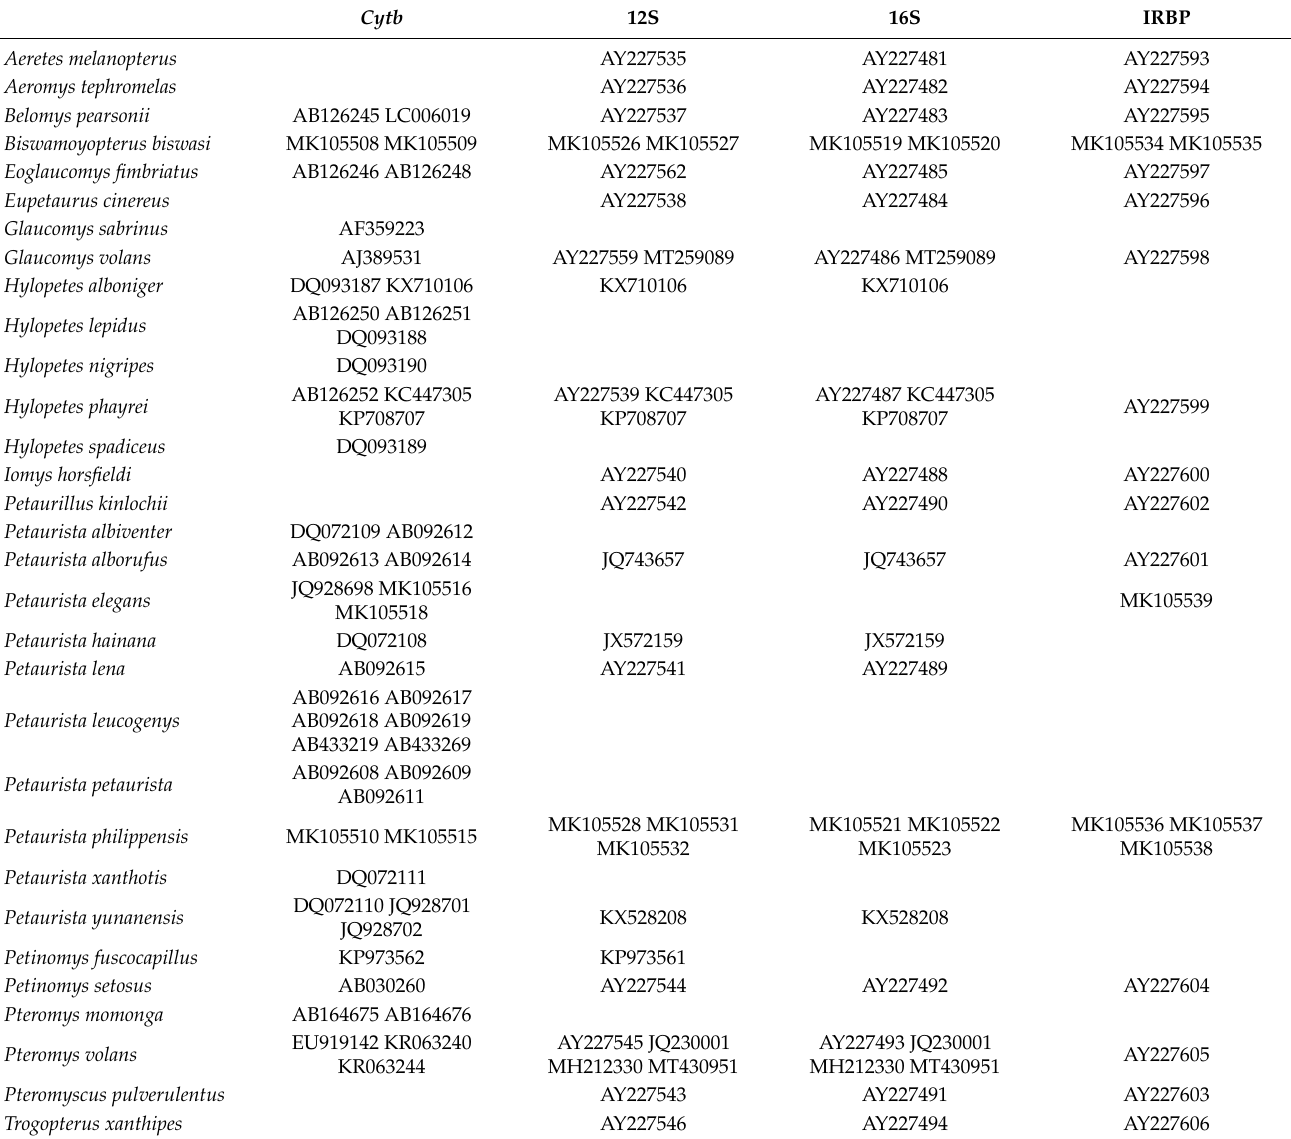
Table 2. Accession numbers of the GenBank sequences analyzed in the current